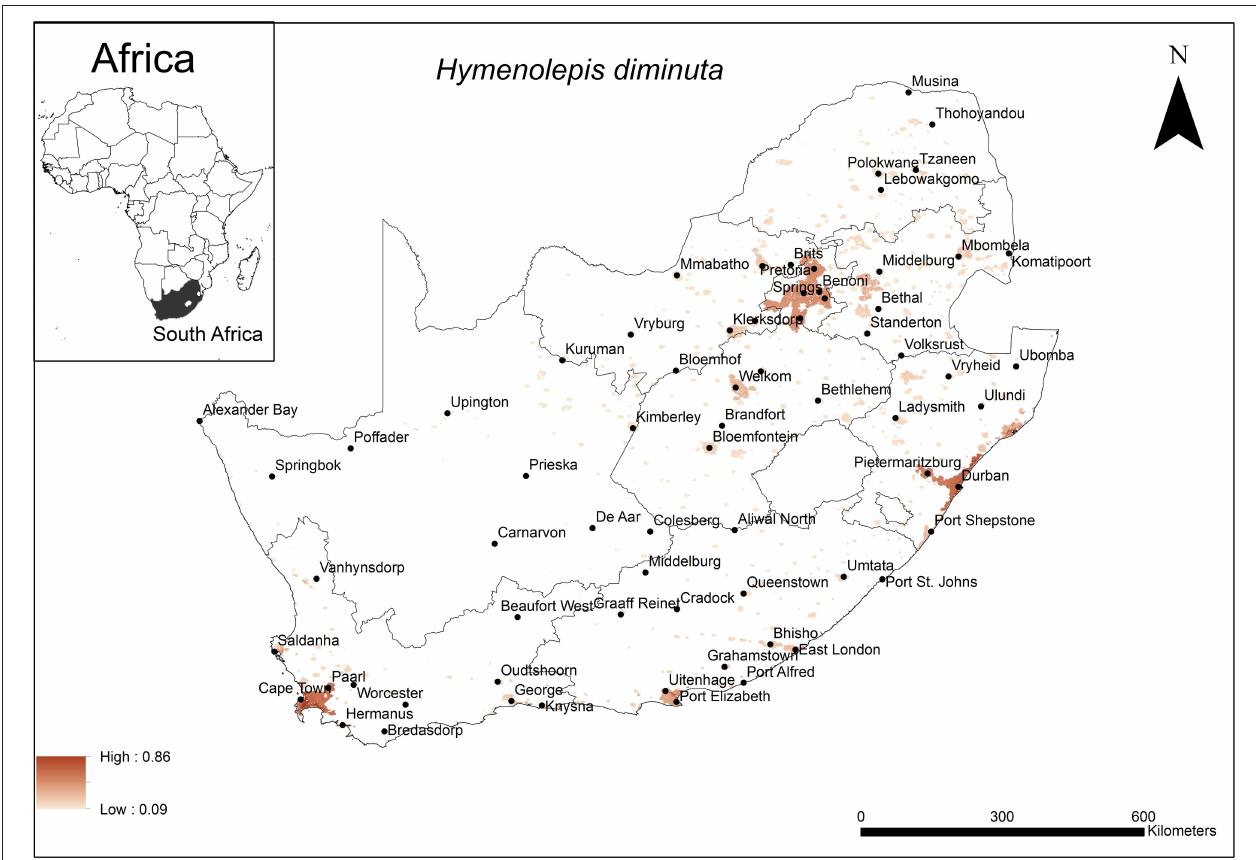
FIGURE 4 | A map showing predicted occurrence of H. diminuta in South Africa based on environmental suitability (shaded areas). White (non-shaded) areas represent areas where data were unavailable.